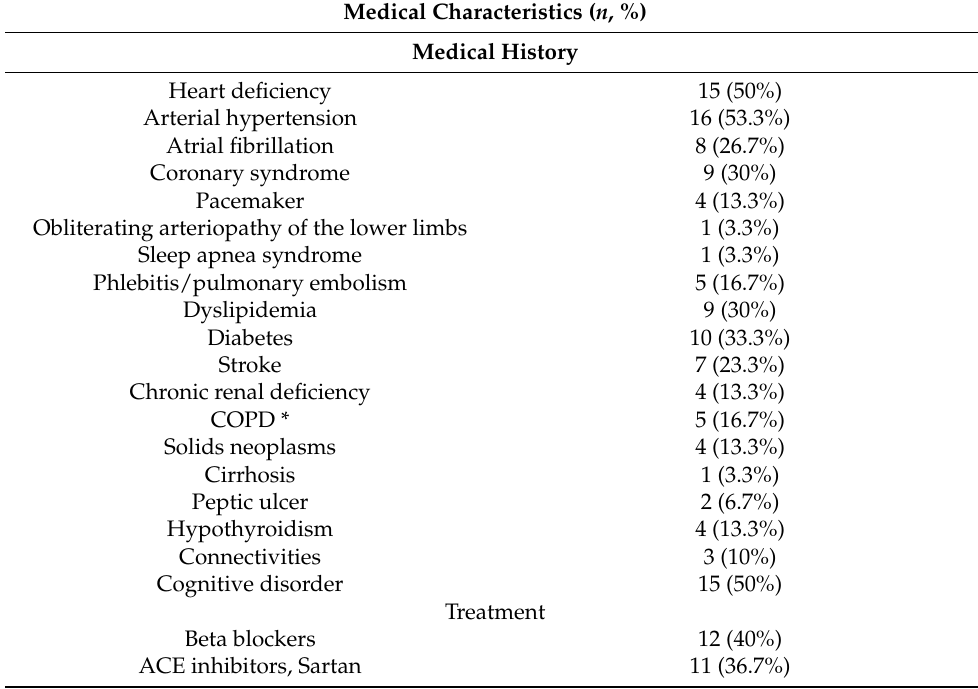
Table 2. Characteristics of the study population ( n =